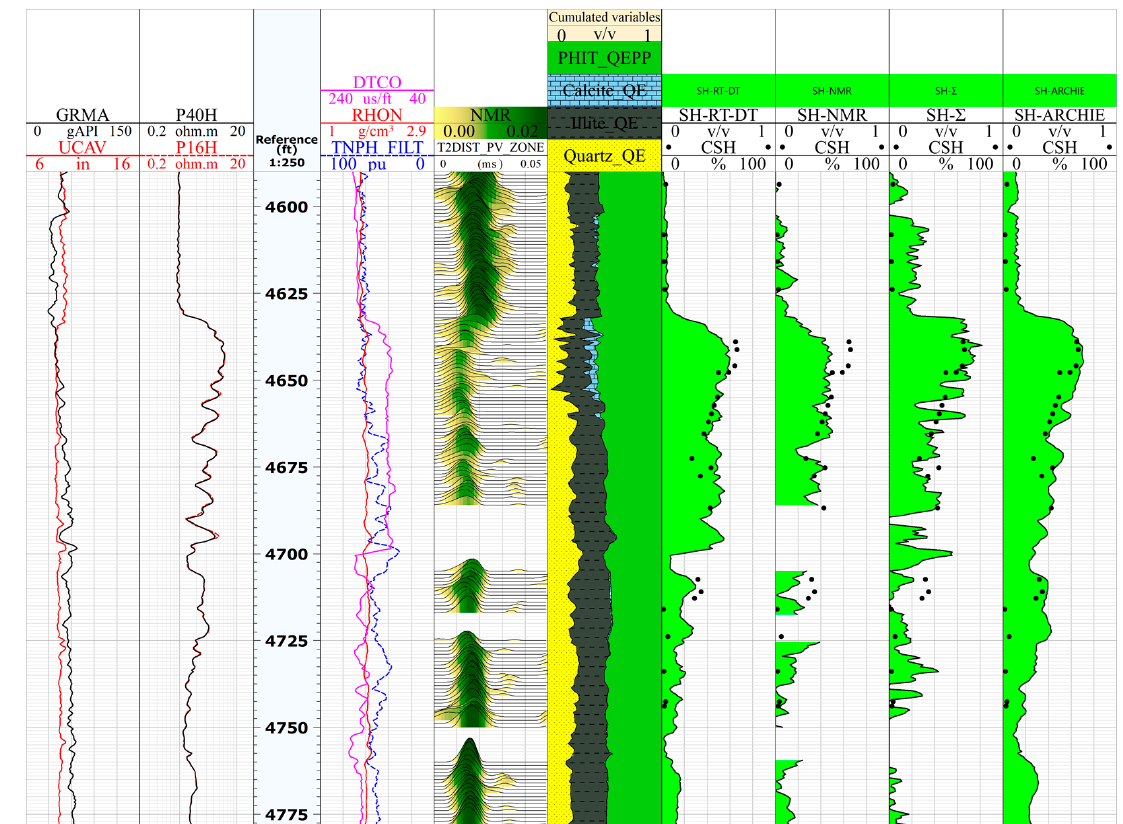
Figure 11. Comparison of various logging saturation calculation methods for Well W3.